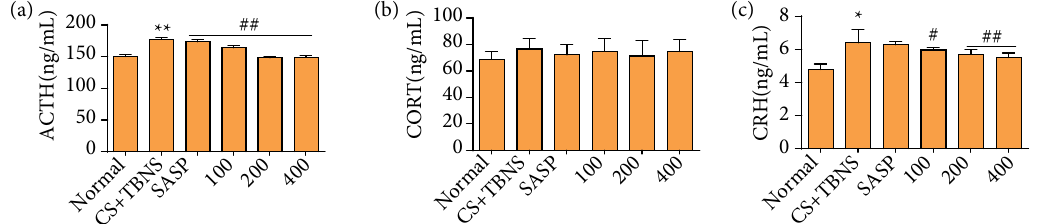
Figure 5 - The effect of Periplaneta americana L. on the HPA axis in rats after chronic stress with ulcerative colitis. The level of (a) ACTH, (b) CORT, and (c) CRH was measured by ELISA. Periplaneta americana L. modulates CD4 + /CD8 + ratio in ulcerative colitis induced by a combination of chronic stress and TNBS in rats